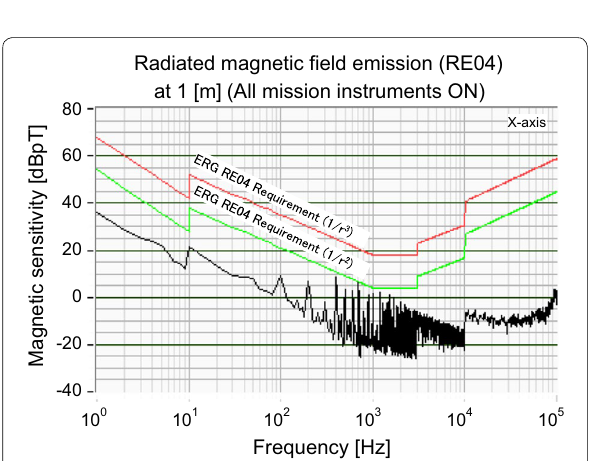
Fig. 7 Radiated magnetic field noise (RE04) measured in the system electromagnetic compatibility (EMC) test. There are two levels of requirements for each instrument: The emission level must be attenuated in proportion to the square or the cube of the